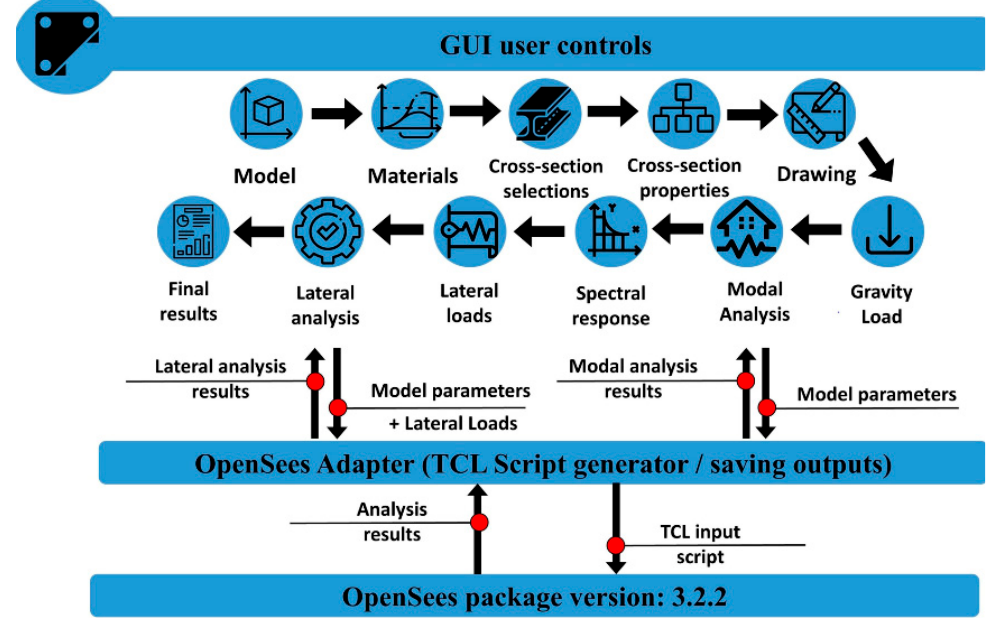
Figure 6. Flow chart of INSPECT-SPSW architecture.